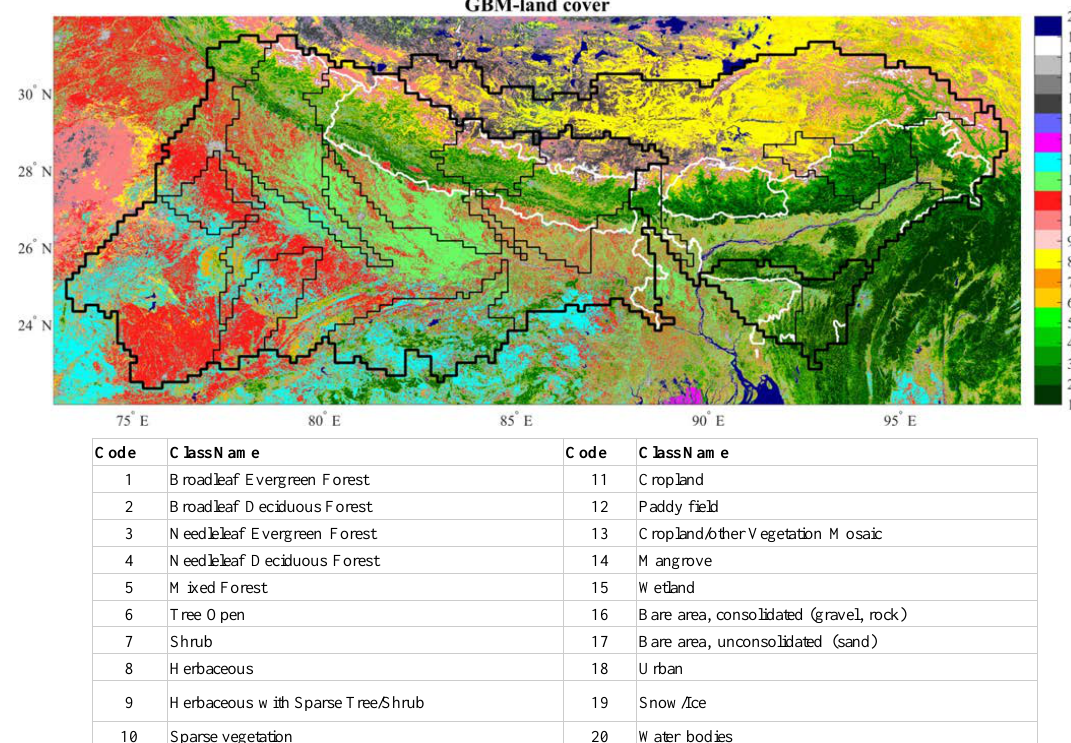
Figure 2. Land cover of the GBM basin from GLCNMO (Tateishi et al., 2014).